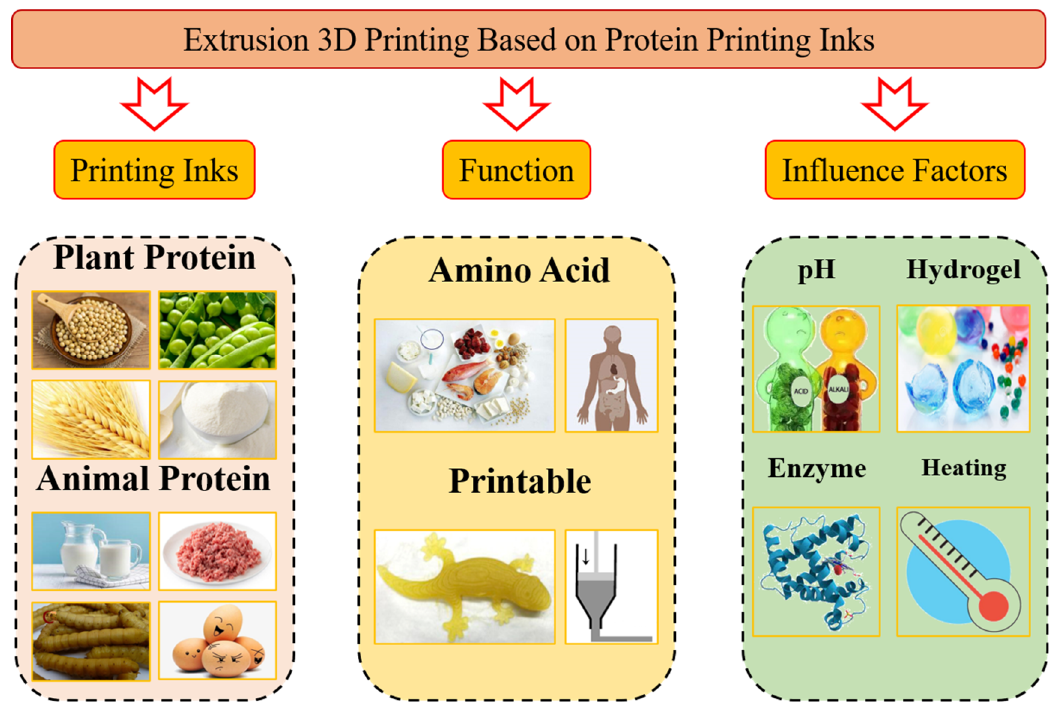
Figure 2. Schematic diagram of major analytical steps considered for 3D printed protein-based prod- ucts: printing inks, function, influencing factors, and